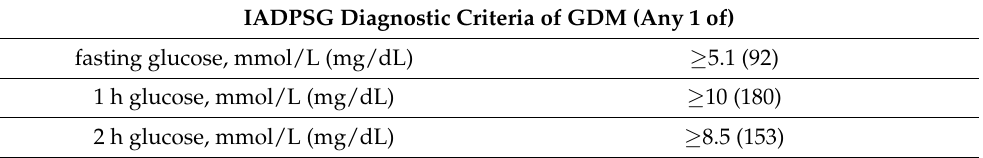
Table 1. GDM diagnostic criteria according to the International Association of Diabetes and Preg- nancy Study Groups (IADPSG) [18]. IADPSG Diagnostic Criteria of GDM (Any 1 of) fasting glucose, mmol/L (mg/dL) ≥ 5.1